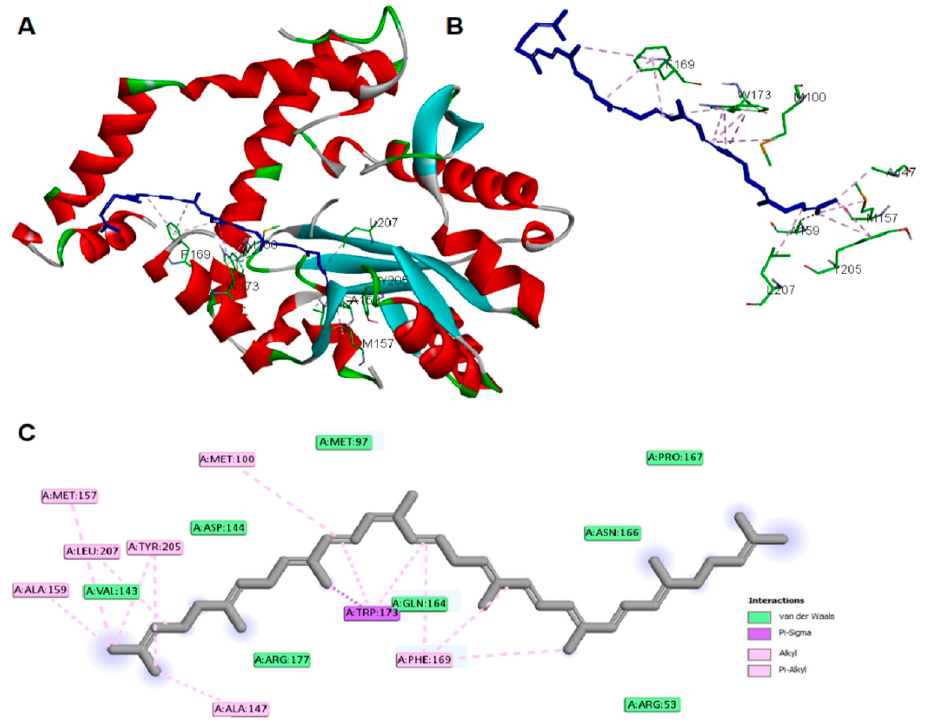
Figure 5. Docking of lycopene in K. pneumoniae lipid A biosynthesis myristoyl transferase (LBMT) ( A ) whole protein view ( B ) active site view, and ( C ) the 2D schematic presentation of interaction forces.